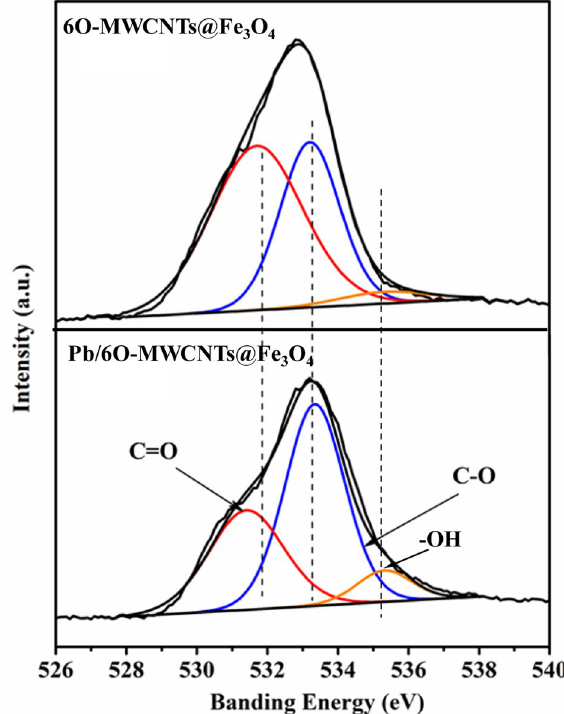
Figure 11. Typical deconvoluted peaks of O1s before and after adsorption of Pb(II).